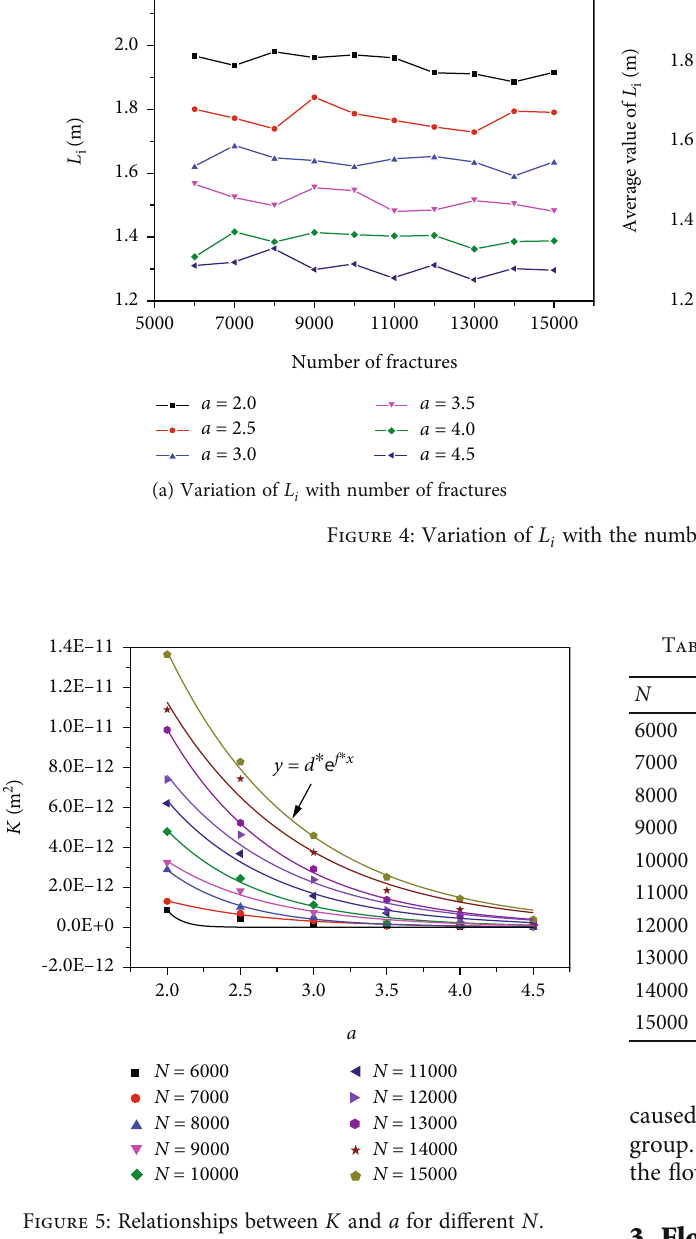
Figure 5: Relationships between K and a for di ff erent N .